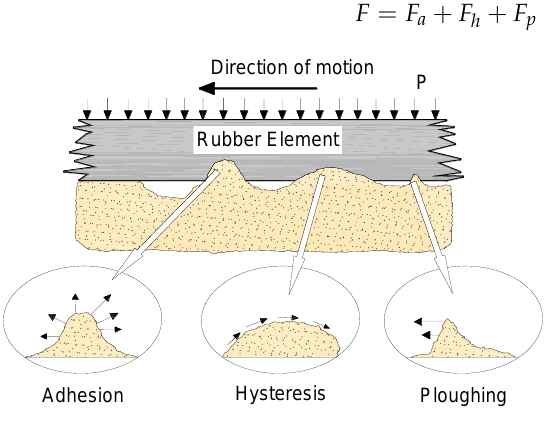
Figure 1. Tire – pavement friction. Figure 1. Tire–pavement